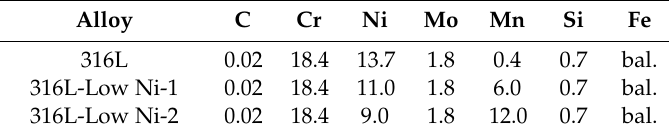
Table 1. Chemical composition of the raw material 316L and modified 316L (in mass %). Alloy C